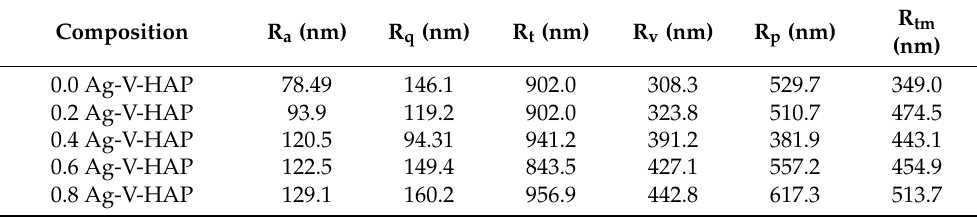
Table 2. Surface roughness parameters of Ag-V-HAP powder with different silver content. Parame- ters include the roughness average (Ra), root mean square (Rq), maximum height (Rt), maximum valley depth (Rv), maximum peak height (Rp), and average maximum height (Rtm).